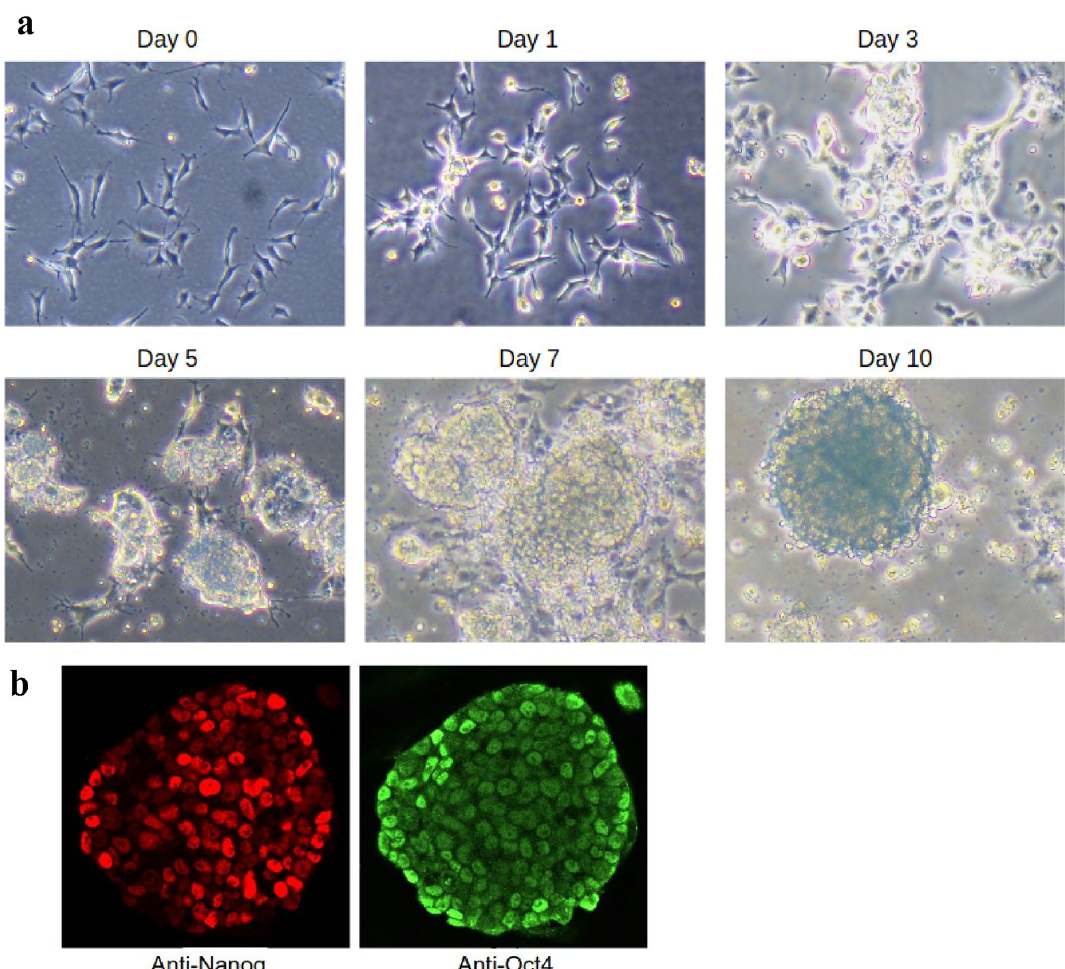
Figure 1. Reprogramming of neural progenitors into the pluripotent iPS cells. (a) Colony formation during the iPS reprogramming of neural progenitors. The truly round-shaped colonies with a characteristic “glow” indicative of reprogrammed cells appear between days 7 and 10. ( b) The results of the immunofluorescent analysis of nascent colonies for pluripotency markers Nanog and Oct4 (Day